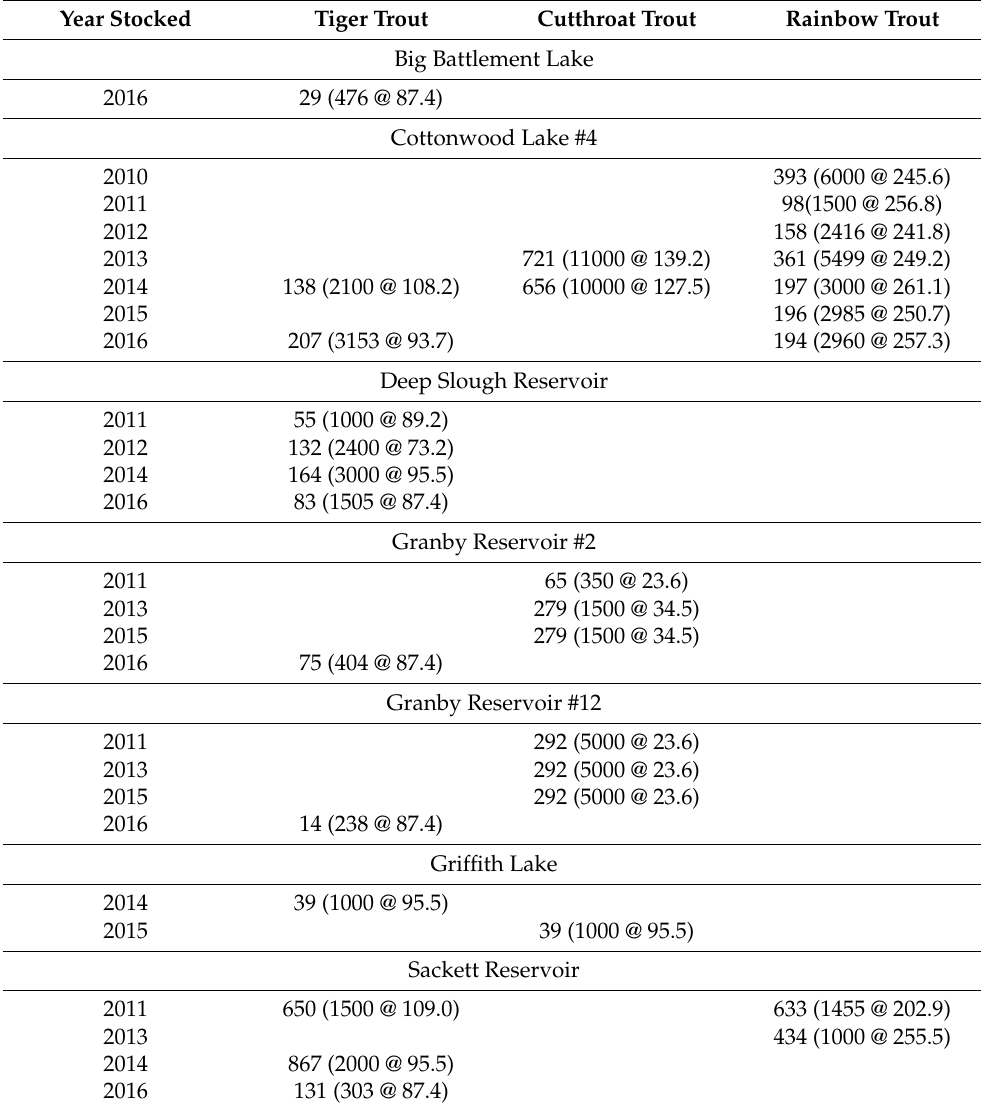
Table 2. Stocking history for each study system prior to 2017 field sampling. Values represent the annual stocking density (number/ha) of different salmonid sport fish. Values inside parentheses represent the total number of fish stocked (listed first) and the mean total length (mm) of fish stocked as measured by the hatchery (e.g., 476 @ 87.4 indicates 476 individuals were stocked with a mean length of 87.4 mm). Although not listed, Cottonwood Lake #4 also received golden trout ( O. aguabonita ) at ~11 fish/ha (161 @ 202.9 mm) in 2013, and Deep Slough Reservoir received brook trout at 74 fish/ha (1350 @ 77.0 mm) in 2011. Year Stocked Tiger Trout Cutthroat Trout Rainbow Trout Big Battlement